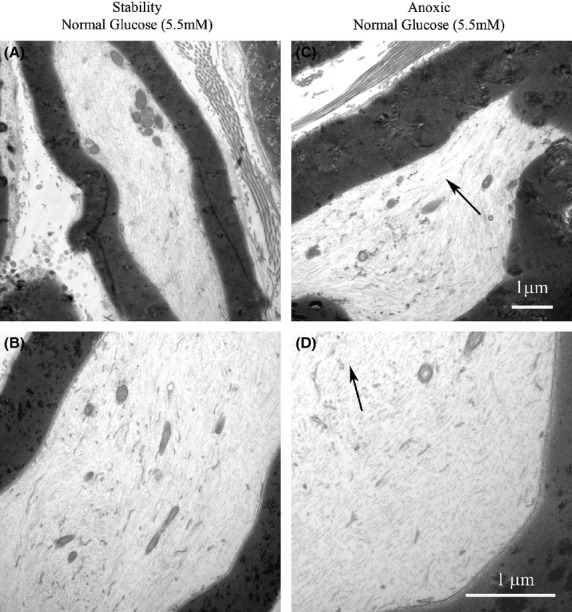
Electron micrographs of nerves that were and were not exposed to anoxia with a glucose concentration of 5.5 mmol/L. (A, B) Intact axons with well-defined axoplasm, cytoskeleton, and neurofilaments (a = 12,500X, b = 31,500X). (C, D) Degeneration of axons with loss of neurofilaments and axoplasm becoming granular (arrows) (c = 12,500X, d = 31,500X).